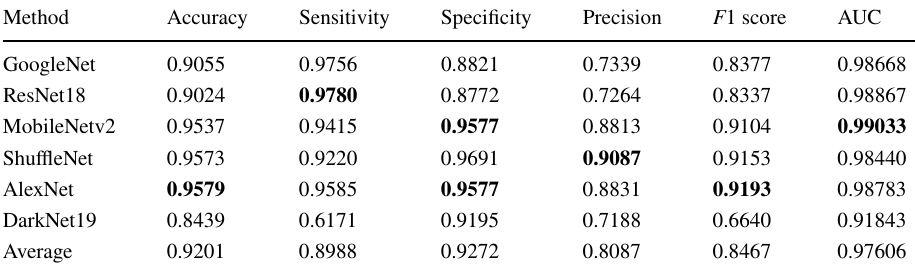
The values indicated in bold in the columns represent the highest